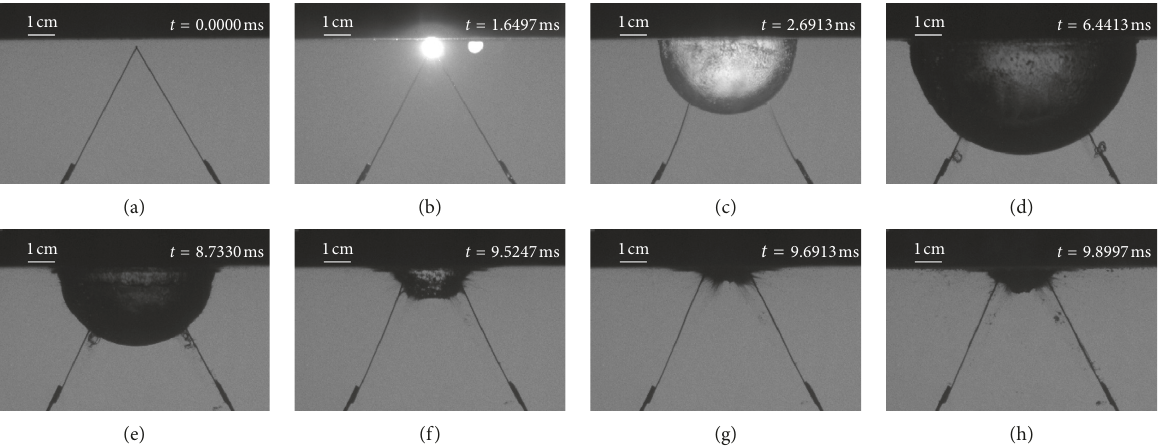
Figure 10: Evolution of the first cycle of the underwater spark-generated bubble’s expansion and collapse below the target plate with 3mm standoff. (a) t � 0.0000ms. (b) t � 1.6497ms. (c) t � 2.6913ms. (d) t � 6.4413ms. (e) t � 8.7330ms. (f) t � 9.5247ms. (g) t � 9.6913ms. (h) t � 9.8997ms.